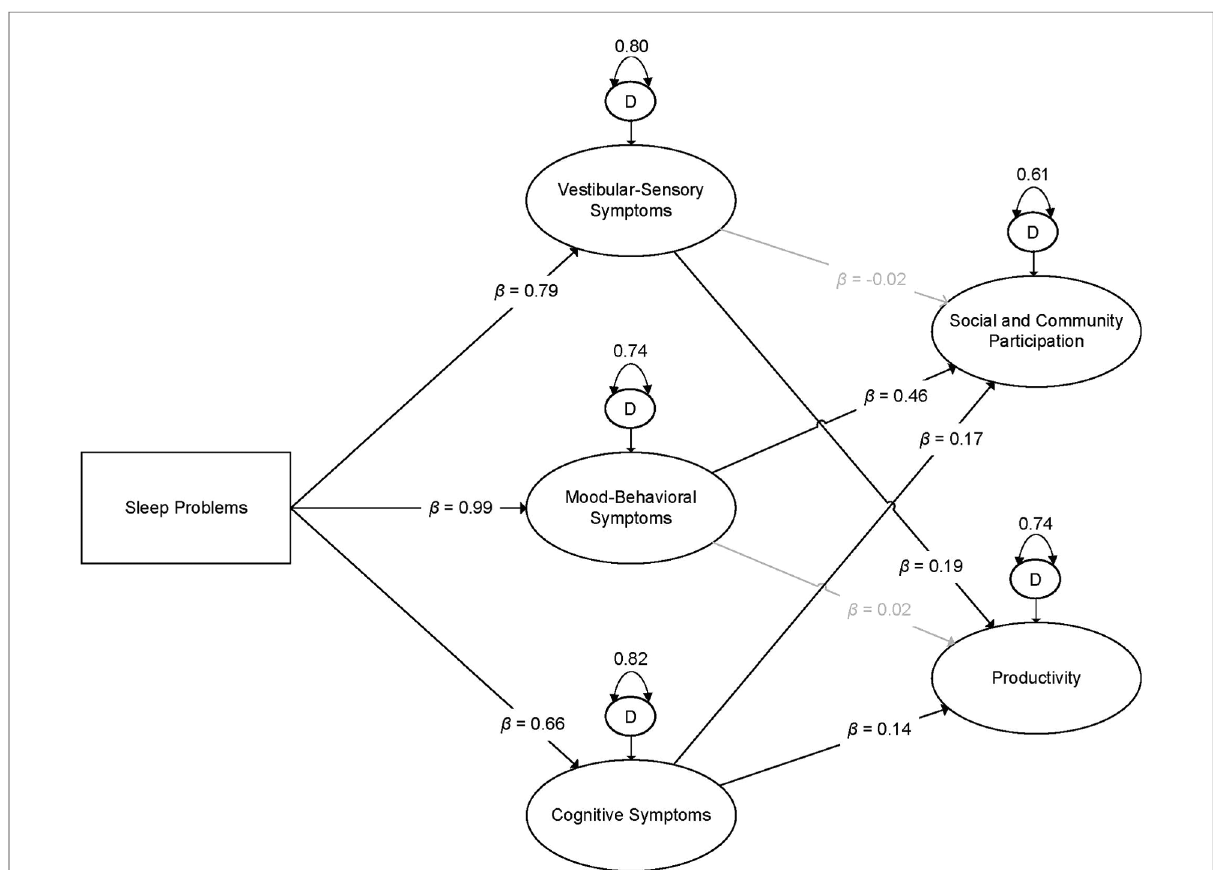
FIGURE 1 Visual illustration of the fi nal latent variable path model. Boxes indicate observed variables; ovals indicate latent indicators. Dark lines indicate estimates that were statistically signi fi cant at α =0.05; gray lines indicate relationships that were not statistically signi fi cant. β =standardized estimate; D=disturbance term (i.e., residual variance of latent indicator). All estimates are adjusted for sociodemographic, injury-related, and co-morbidity co-variates.